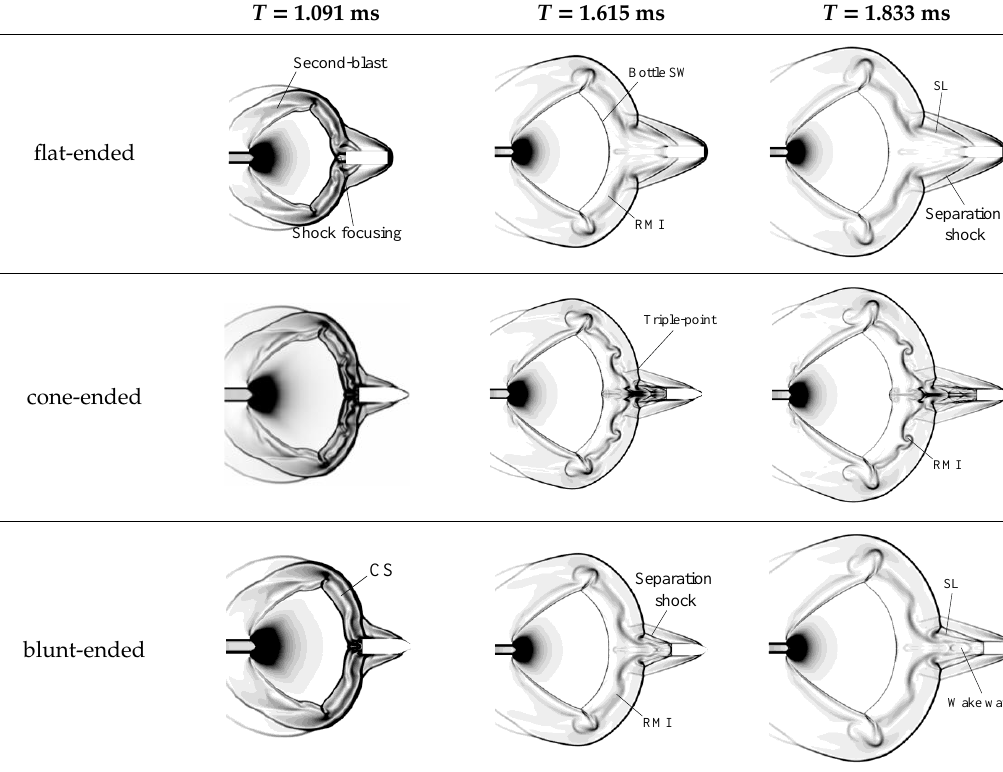
Table 3. Richtmyer–Meshkov instability (RMI) Schlieren comparison.